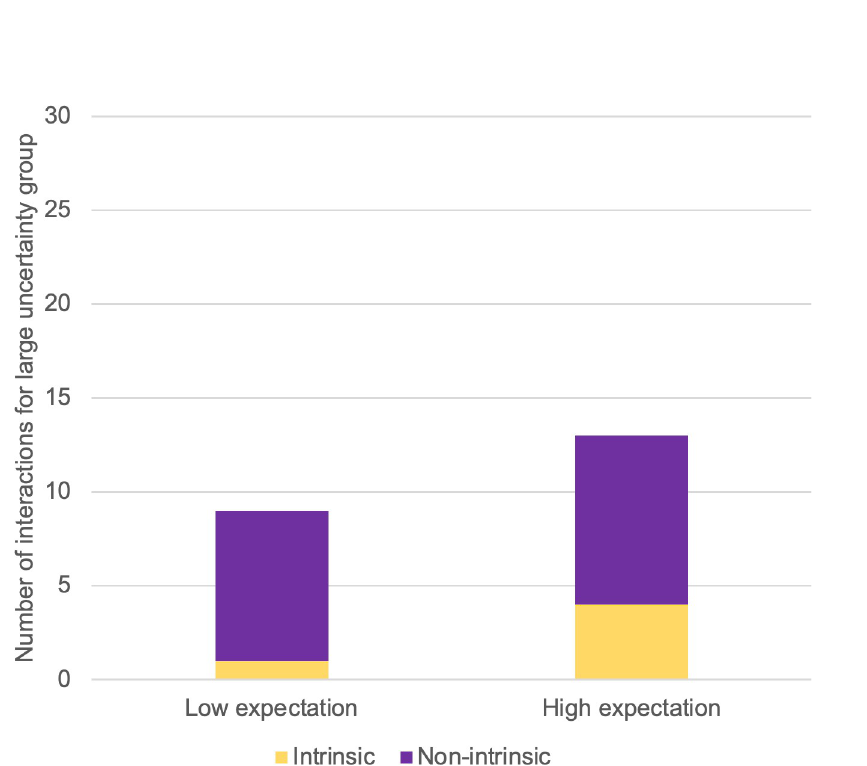
Fig 13. Numbers of interactions for large-uncertainty group, sorted by motivation type.